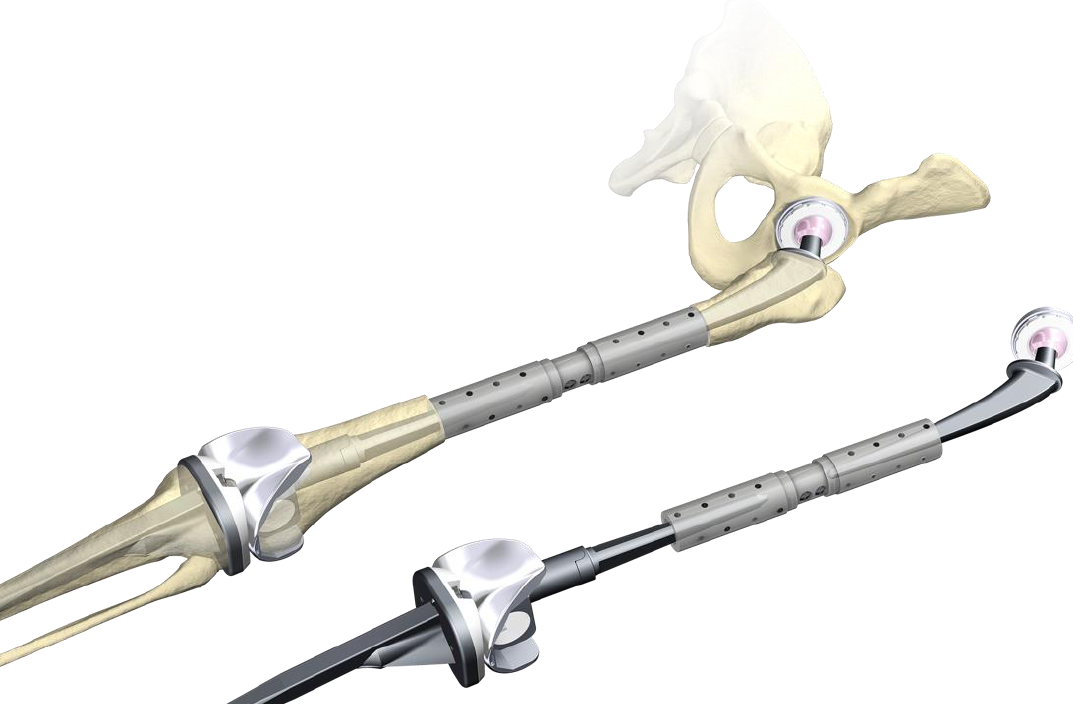
Figure 5. Custom-made interposition sleeve (Waldemar Link GmbH, Hamburg, Germany).